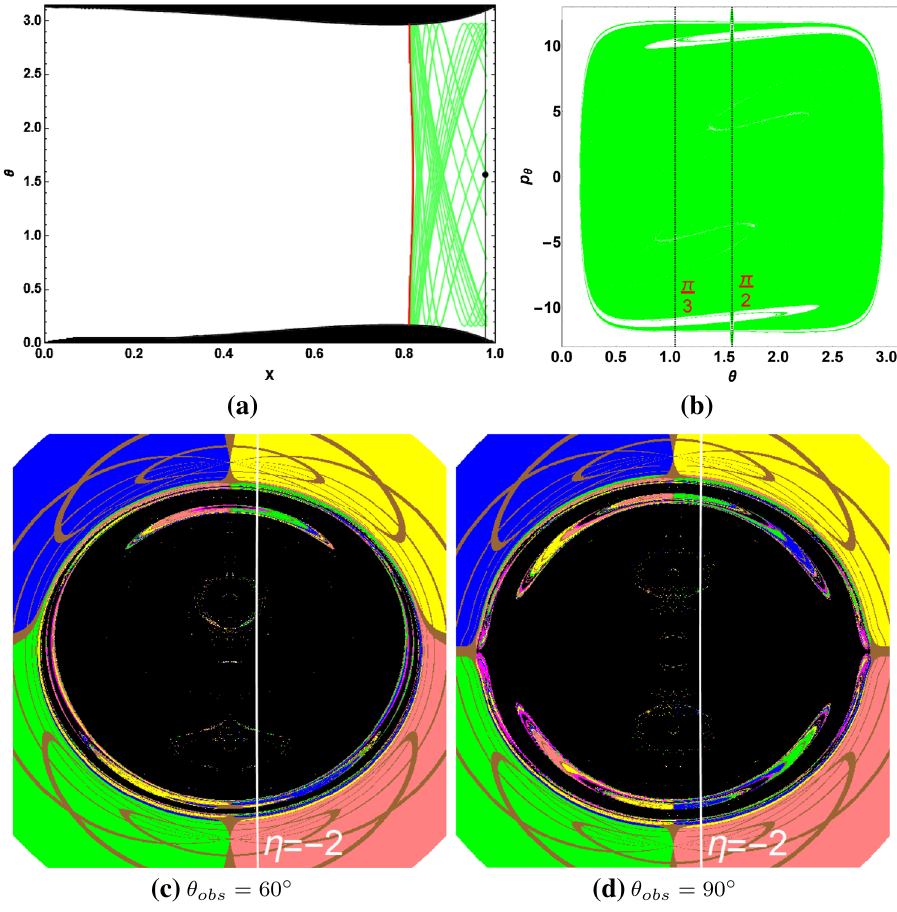
Fig. 4 Light ring (dot) and the families of periodic Lyapunov orbits (solid line) in the spacetime of a Schwarzschild black hole surrounded by a Bach–Weyl ring with M = 1 . 5 M and Weyl radius b = 3 M